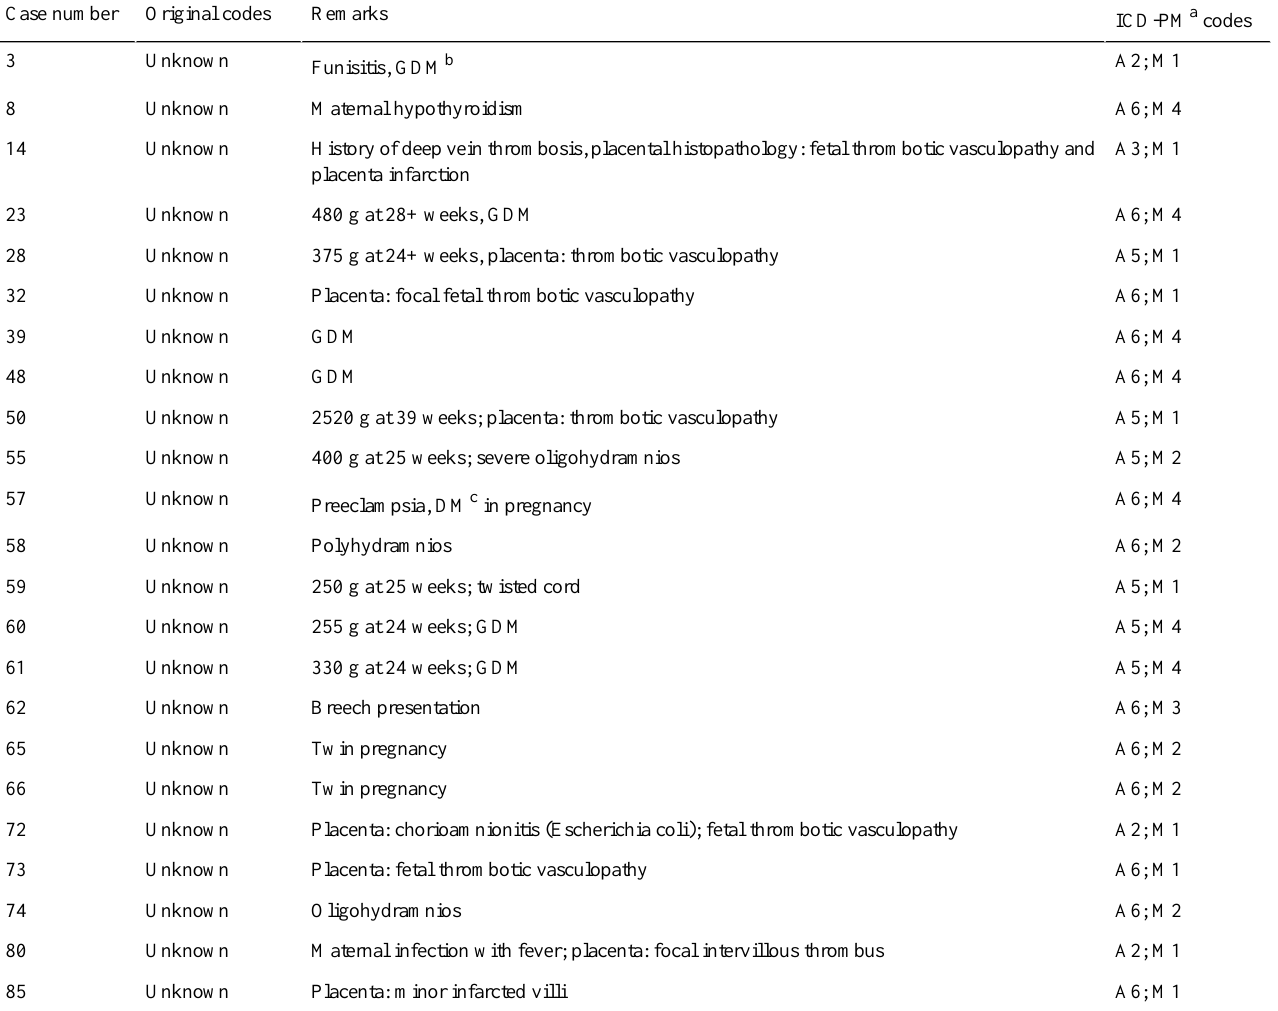
Table 3. In the retrospective 5-year validation study (May 1, 2012, to April 30, 2017), 23/30 unknown causes of stillbirth can be assigned a diagnosis category after applying ICD-PM